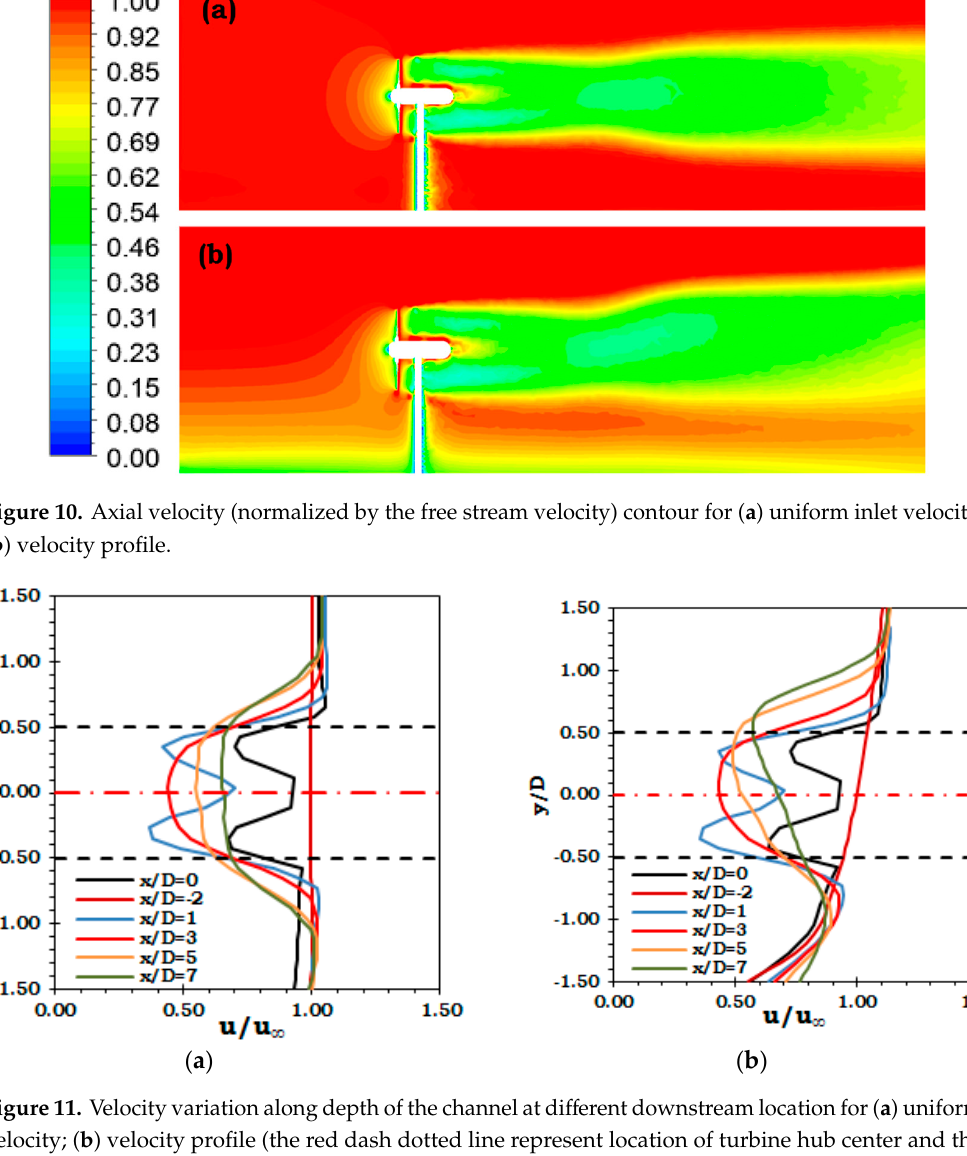
Figure 11. Velocity variation along depth of the channel at different downstream location for ( a ) uniform velocity; ( b ) velocity profile (the red dash dotted line represent location of turbine hub center and the black dashed lines represent the extent of blade tips).